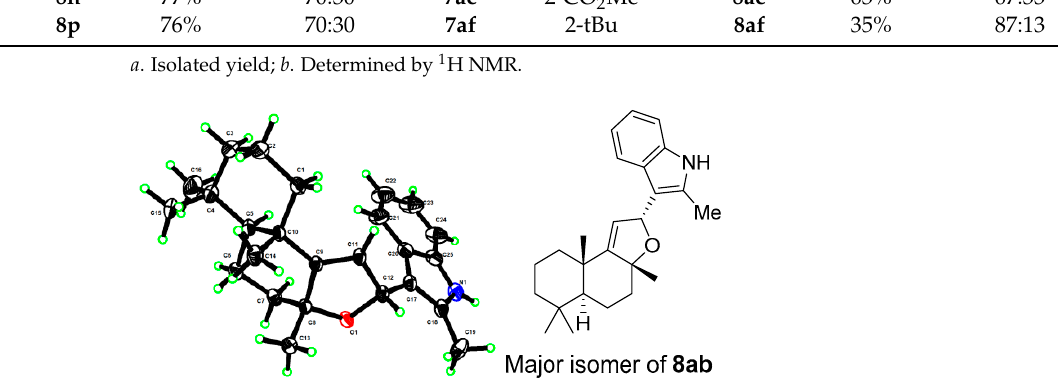
Figure 3. Structure of the major isomer 8ab determined by single-crystal X-ray diffraction, CCDC code: 2,236,373 [34].